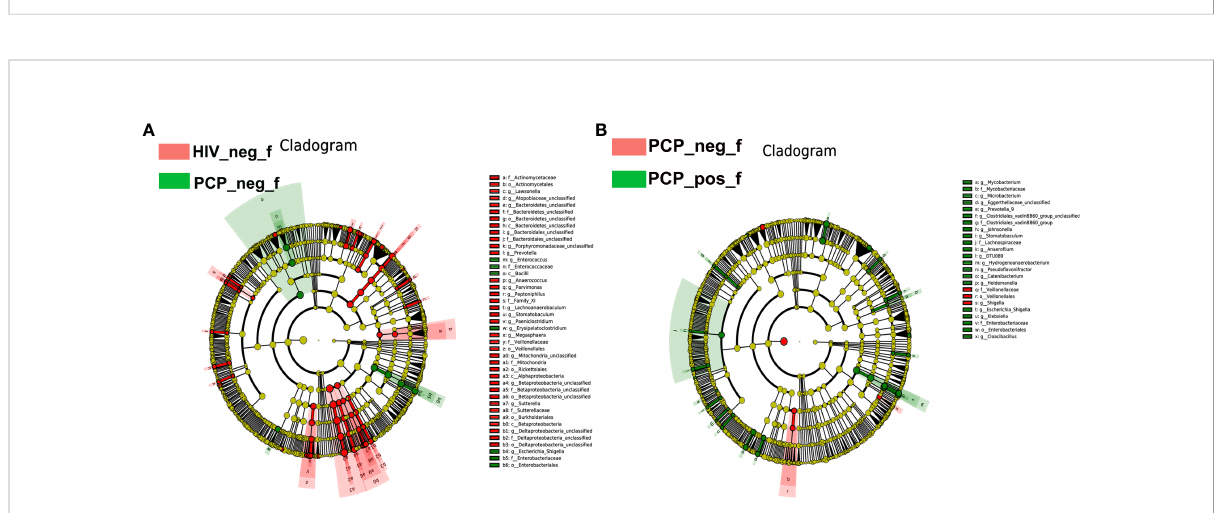
FIGURE 4 LEfSe diagram analysis of intestinal fl ora. Circles from the inside out indicate phylogenetic levels from phylum to genus. (A) LEfSe analysis of evolutionary clades of the gut microbiota in HIV+ and HIV- groups. (B) LEfSe analysis of evolutionary clades of gut microbiota in PCP+ and PCP- groups. HIV_neg_f: HIV- group; PCP_pos_f: HIV+PCP+ group; PCP_neg_f: HIV+PCP-